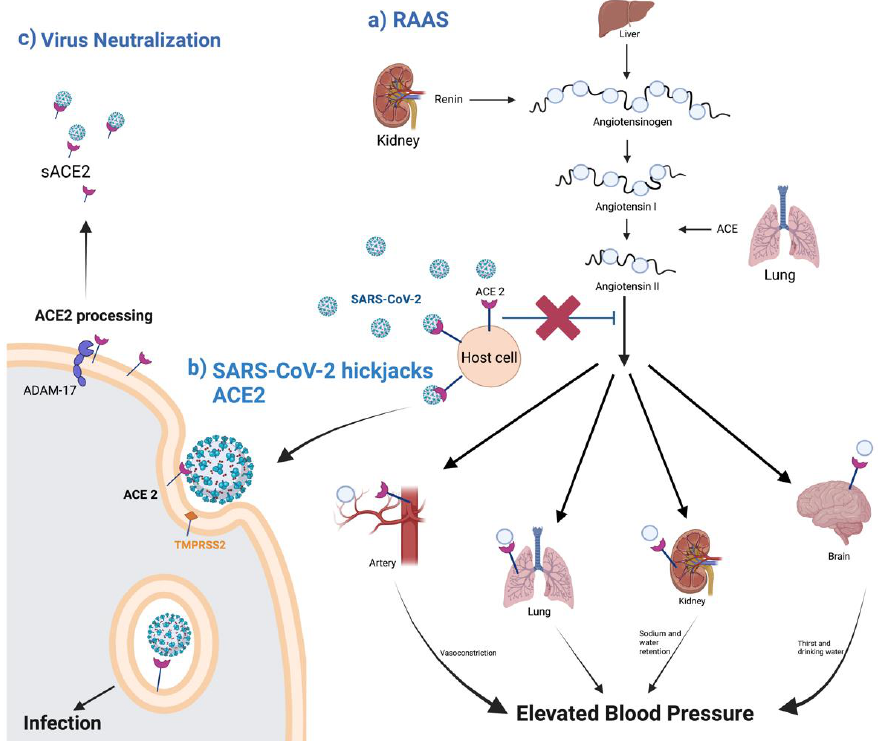
Figure 2. A schematic diagram of ACE2 pathways. ( a ) the regulation of the renin – angiotensin system. ( b ) ACE2 as SARS-CoV-2 receptor, leading to the internalization and infection of the virus. ( c ) ACE2 processing by ADAM-17, leading to the release of sACE2 and the possible blockage of SARS-CoV-2 infection. Created with